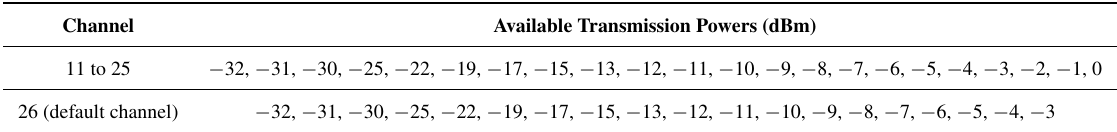
Table 2. Available transmission powers in the SunSPOT nodes.